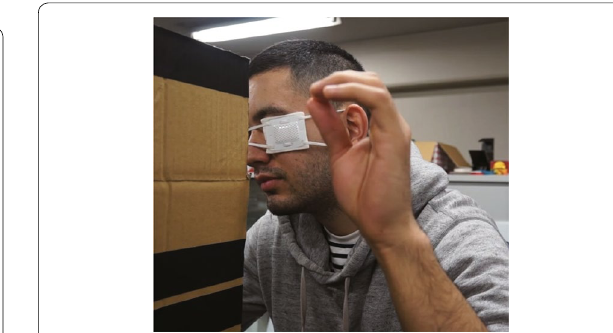
Fig. 4 Experimental environment. Eye bandage and partitions are put to disable visual feedback